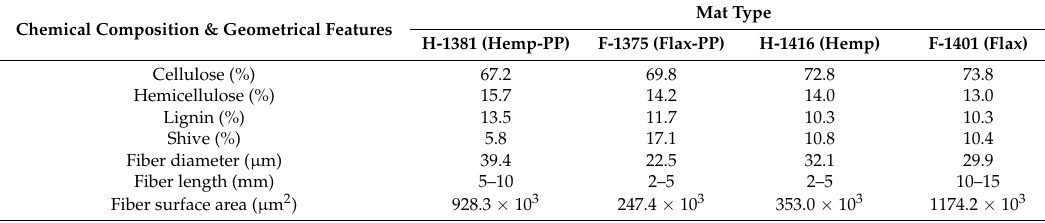
Table 1. Specifications of the natural fibers within the tested nonwoven mats. Polypropylene (PP). Chemical Composition & Geometrical